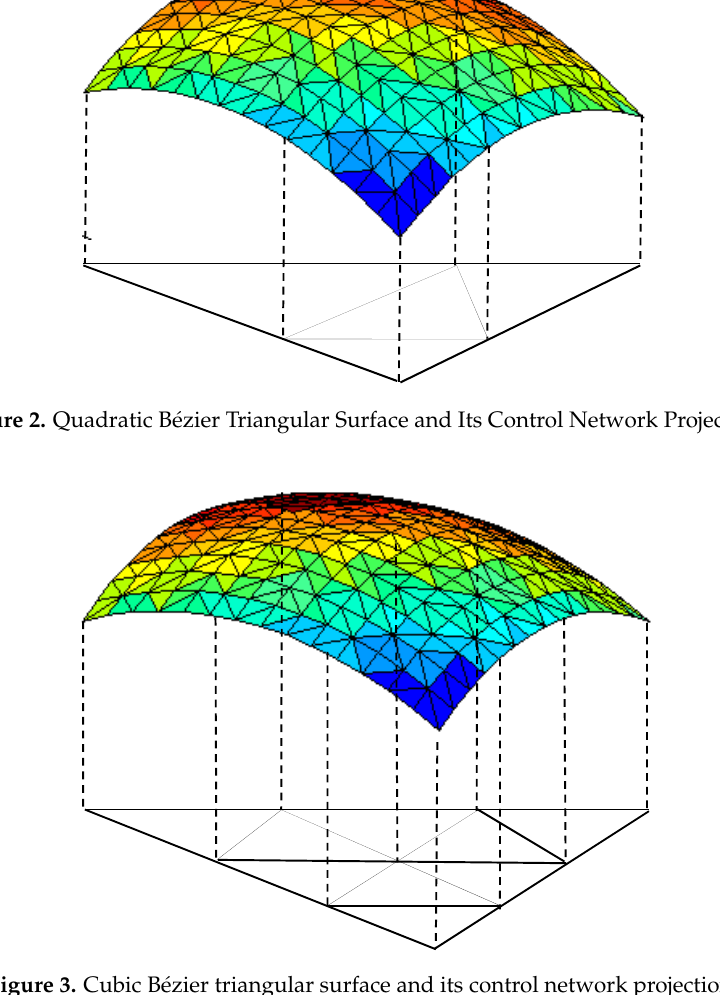
Figure 3. Cubic Bézier triangular surface and its control network projection. Figure 3. Cubic B é zier triangular surface and its control network